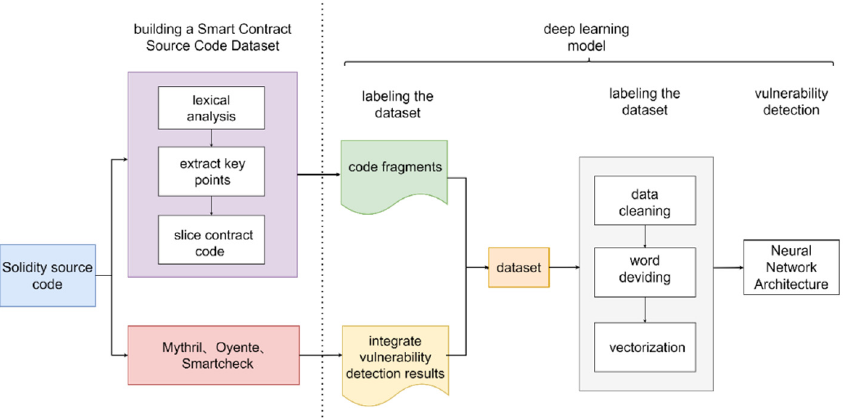
Figure 1. A holistic design solution for smart contract source code vulnerability detection based on deep learning.